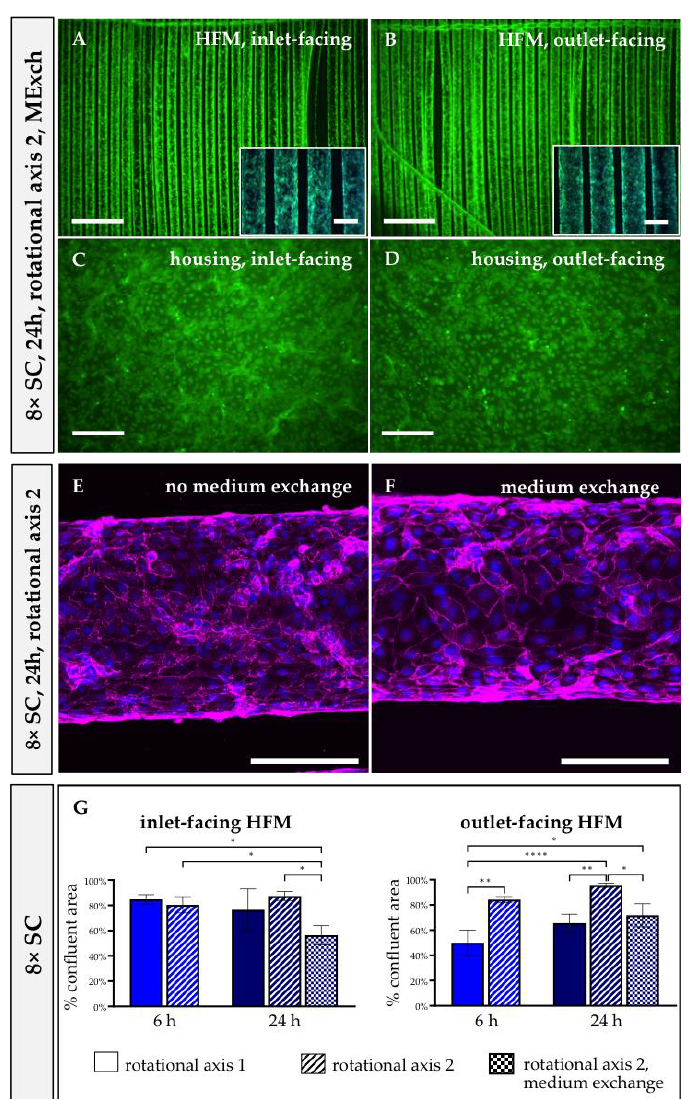
Figure 3. Confluent EML on HFMs remained unaffected after medium exchange during 24 h rotational seeding. Following seeding procedure using 8 × SC for 24 h and RA2, calcein (green) and Hoechst 33342 (blue) staining was performed, and fluorescence microscopy images were taken from HFMs ( A , B ) and housing ( C , D ) either facing the inlet ( A , C ) or outlet ( B , D ). Scale: 2 mm, insert boxes in A, B, scale: 400 µm. ( E , F ) CLSM images for the detection of VE-cadherin (magenta) on HFM samples cultivated without ( E ) or with MExch ( F ). Nuclei were counterstained with Hoechst 33342 (blue). Scale: 200 µm. ( G ) Quantification of the successfully endothelialized HFM area per total available HFM surface. SC: seeding concentration. * p < 0.05, ** p < 0.01, **** p < 0.0001.